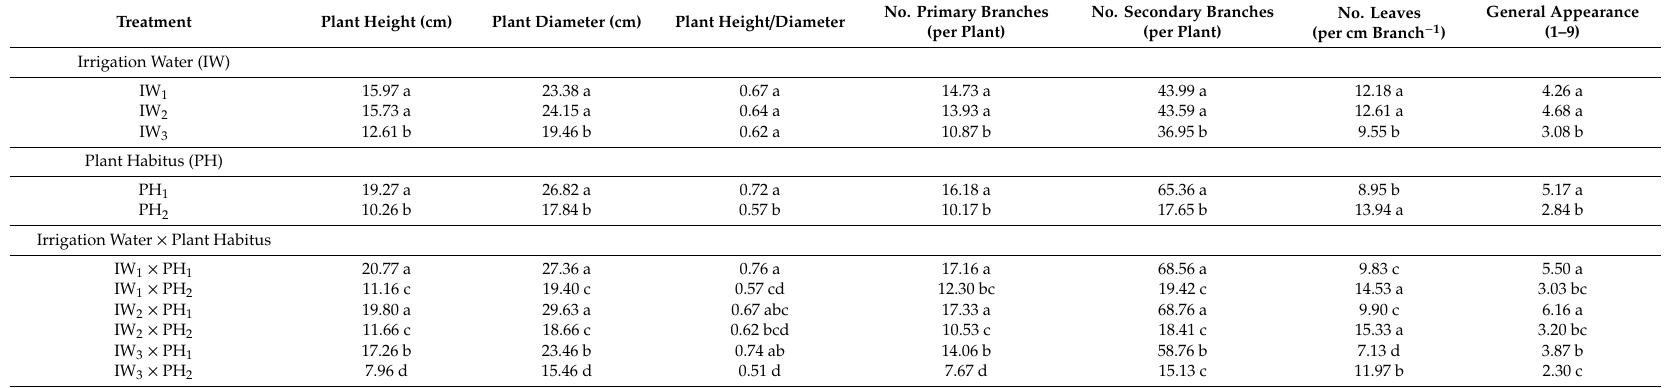
Table 6. Morphological and aesthetic characteristics of erect and prostrate rosemary plants irrigated with FW, TFFSW and FFSW.